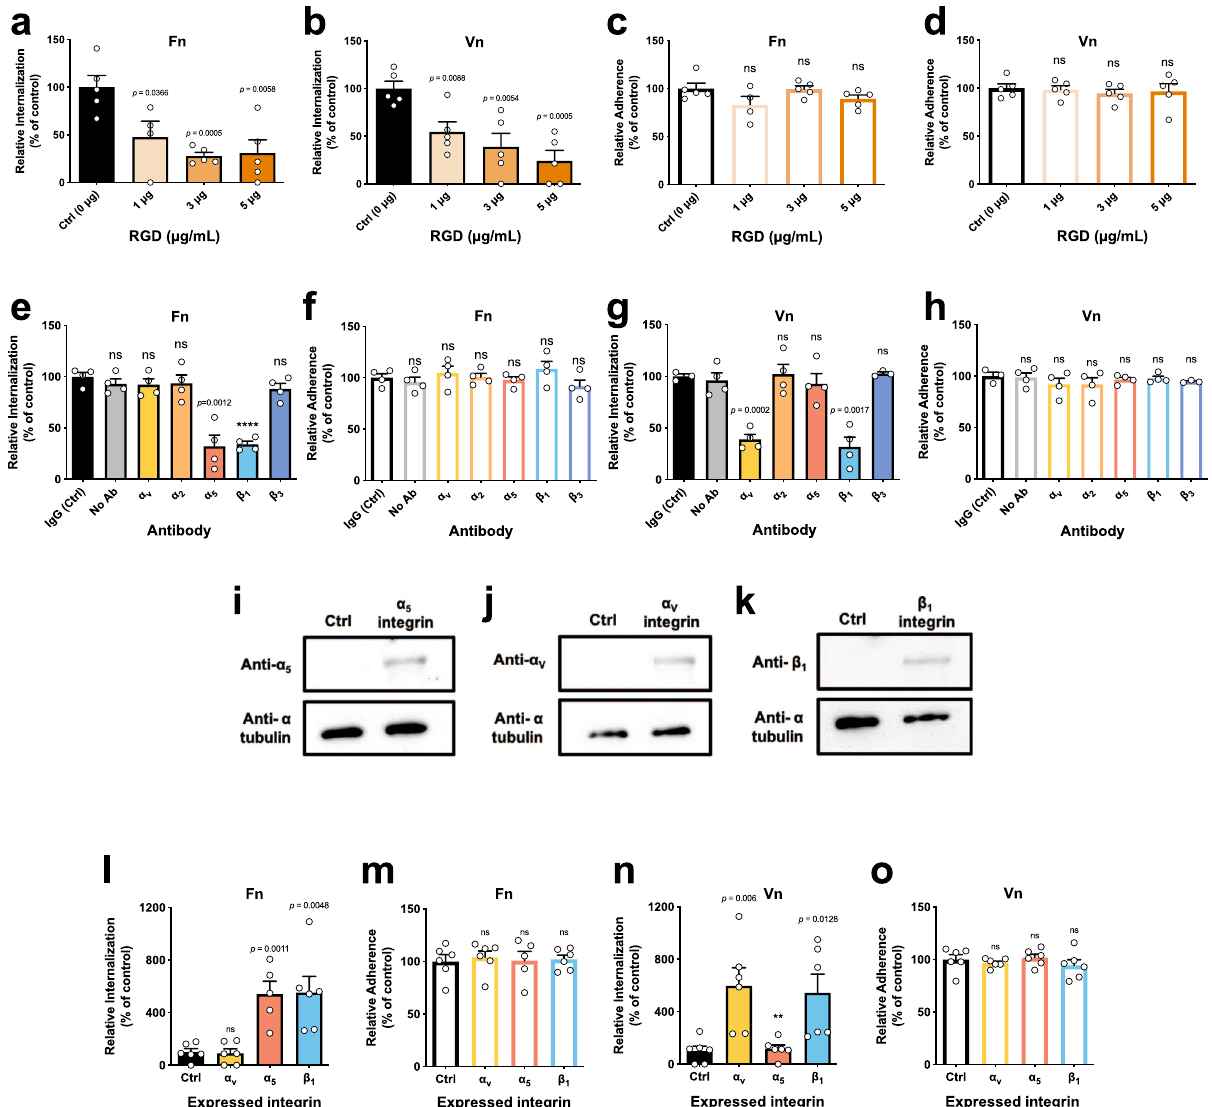
Fig. 4 C. dif fi cile spore internalization via fi bronectin- α 5 β 1 and vitronectin- α v β 1 integrins intestinal epithelial cells. C. dif fi cile spore internalization